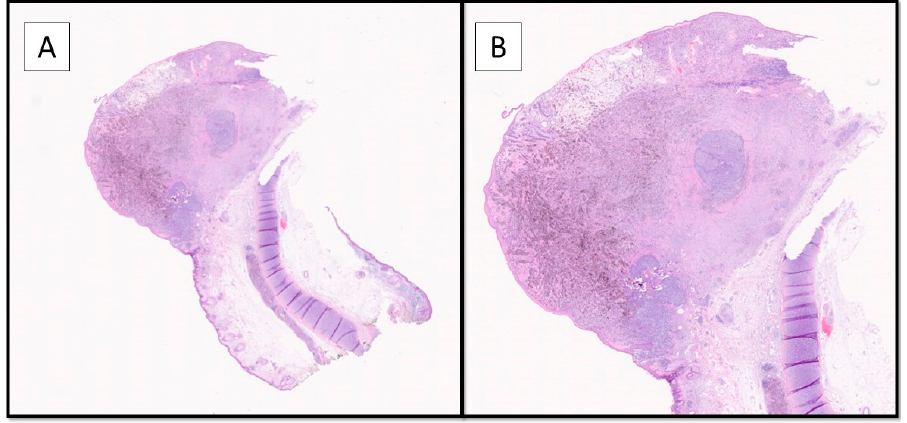
Figure 1. ( A , B ) Posterior and lateral view of an infiltrated nodule, hard on palpation, black and surmounted by a large ulcerative-necrotic area (red circle). In ( B ) two other, different, lesions are apparent (blue and green circles). A 73-year-old man presented at the Plastic Surgery Complex Operative Unit because of the appearance of a lesion that was present from more than two years before, at the level of the left helix, measuring about 18 × 12 mm (red circle, Figure 1), with an ulcerated area on the surface. The medical history was negative for other pathologies and/or neoplasms. After a plastic surgery specialist consultation, the decision was made to remove the lesion together with two other neighboring lesions (blue and green circles, Figure 1B). The samples were histopathologically analyzed.